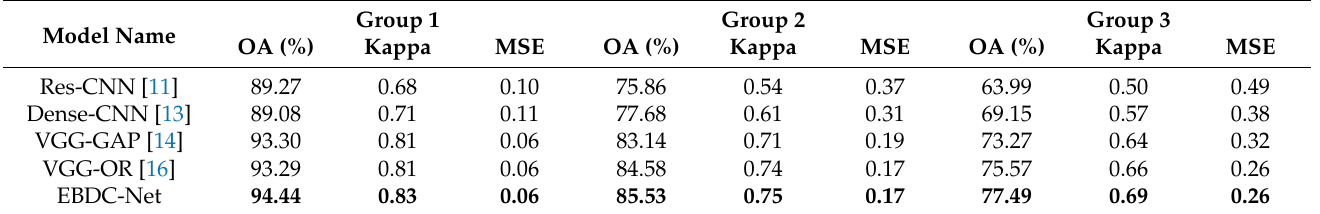
Table 10. Comparison of different methods for the task of classifying building damage in the Ludian dataset.